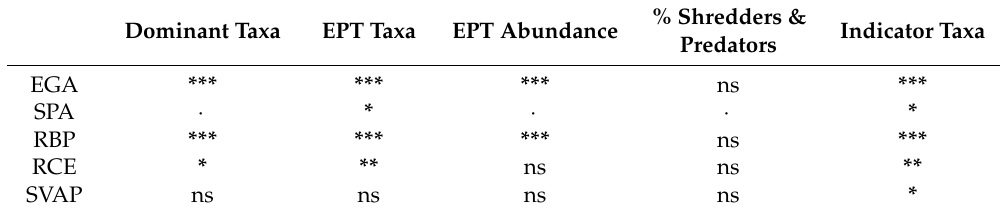
Table 5. Results of slope significance based on p -values obtained from linear regressions of five macroinvertebrate metrics compared to total raw points for five stream assessment methods. n = 65 for all metrics except DIC where n = 52 streams. Significance indicated by *** ď 0.0001, ** ď 0.001, * ď 0.01, ¨ ď 0.05, ns = not